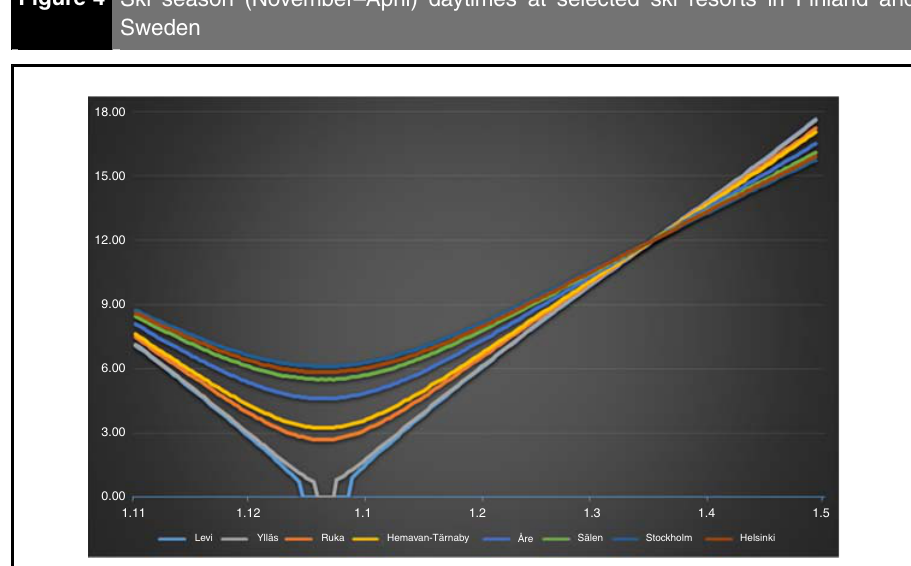
Figure 4 Ski season (November – April) daytimes at selected ski resorts in Finland